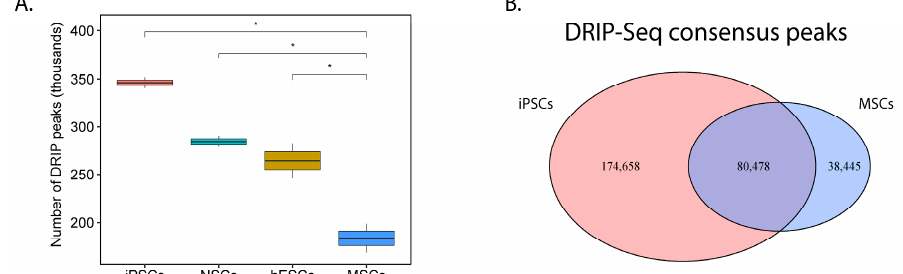
Figure 6. R-loop accumulation is a shared feature of both Ewing sarcoma and its PHATE_1-low developmental context: ( A ) Box-plot comparing number of detected DRIP-Seq peaks (R-loop sites) between cell types found in Ewing sarcoma’s developmental context (iPSCs, induced pluripotent stem cells; NSCs, neural stem cells; hESCs, human embryonic stem cells; MSCs, multipotent mesenchymal stromal cells) (one-tail t test, * p ≤ 0.05); ( B ) Venn diagram comparing DRIP-Seq peaks in iPSCs compared to MSCs.